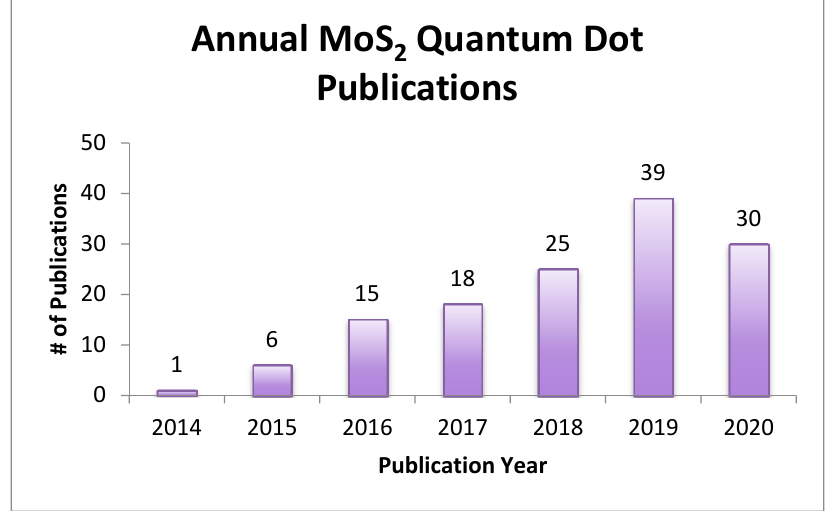
Figure 1. Annual publications on MoS 2 Quantum Dots since 2014 from a Web of Science™ search using search terms “ Quantum Dot ” AND (“ Molybdenum Disulfide ” OR “ MoS2 ”). A steady rise is seen, with the only dip occurring during the 2020 COVID-19 pandemic.